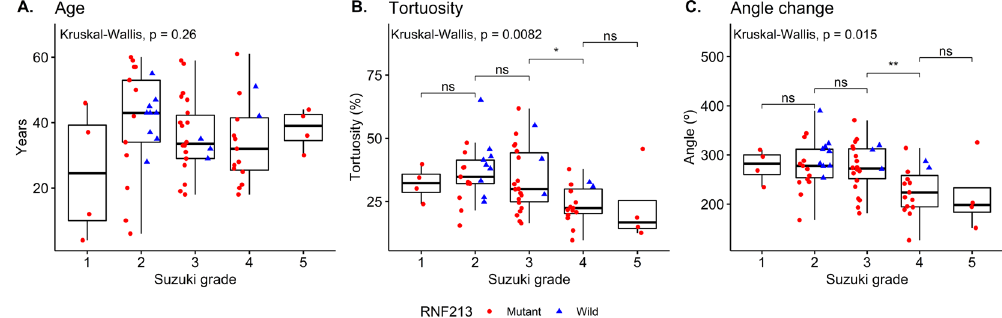
Figure 4. Bar plots with jitters show the distribution of the tortuosity and the angles with corresponding p-values according to Suzuki grade. The shape and color of each jitter represents the mutation status. ns, not significant; * p < 0.05; ** p <